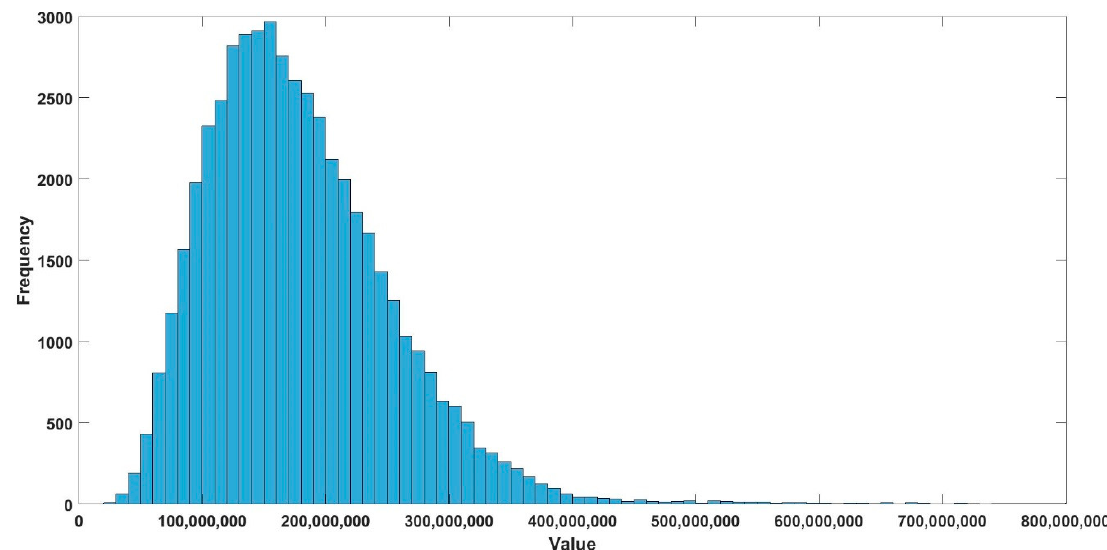
Figure 6. Histogram of the objective function for the greensociety/high value model.